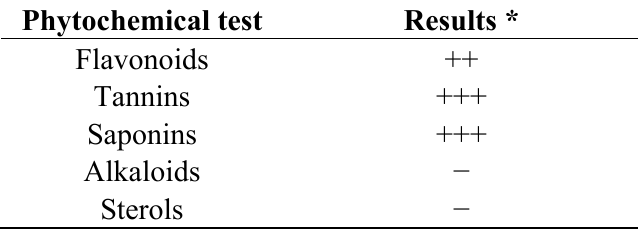
Table 2. Preliminary phytochemical analysis of N. ramboutan-ake aqueous fraction (NRAF).